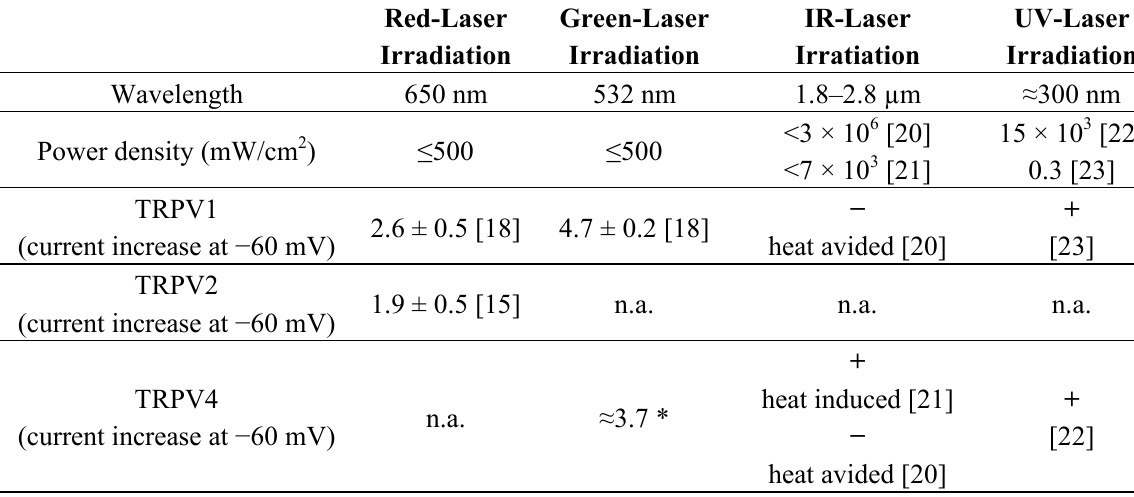
Table 1. Effects of laser irradiation. Numbers in brackets refer to the respective publications, * is from unpublished work (A. Kutschireiter); + stands for stimulation, − for attenuation, n.a. for no data